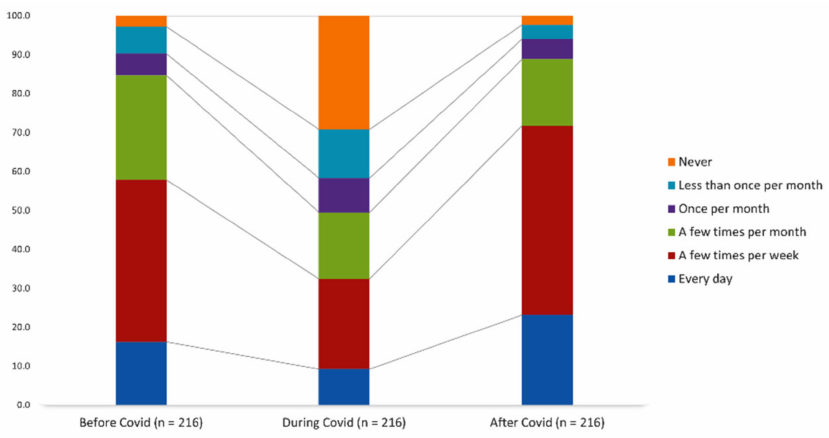
Figure 13. Frequency of UGS visits before, during, and after the COVID-19 restrictions ( n = 216).